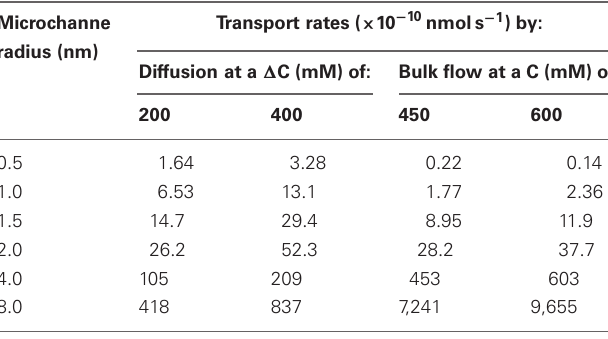
Table 4 | Comparison of estimated transport rates of sucrose by diffusion and by bulk flow through a specified range of plasmodesmal microchannel radii each with a length of 500nm for reported sucrose concentrations (C) in SEs a and vascular parenchyma cells b of developing wheat grains. Microchanne Transport rates ( × 10 − 10 nmols − 1 )